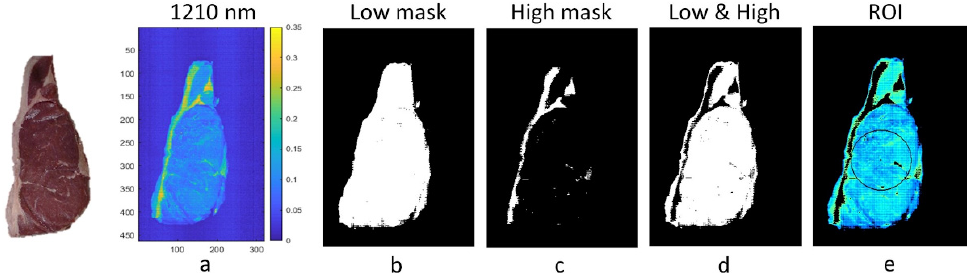
Figure 4. Low and high masks of a meat sample: ( a ) the image in band 1210 nm was used to select the threshold values; ( b ) image after applying the low mask; ( c ) image after applying the high mask; ( d ) image after combining the low and high masks; ( e ) inner ring as the region of interest for the calibration